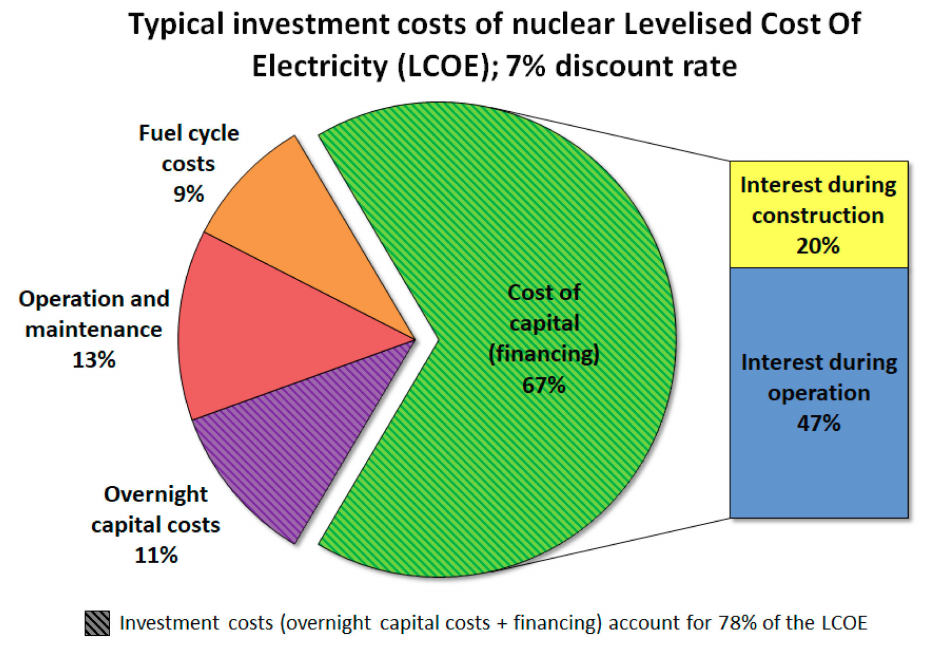
Figure 2. The extent to which up-front capital costs dominate (78%) in the construction of LWR nuclear power plants. 67% of the LCOE for nuclear power can be attributed to the cost of borrowing. Any attempts to reduce nuclear’s LCOE should therefore be focused on the cost of borrowing. Reproduced from [32], NEA: 2020.